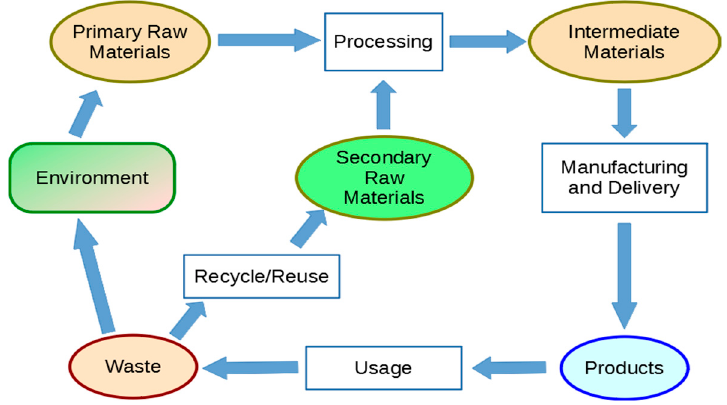
Figure 3. Global material cycles.